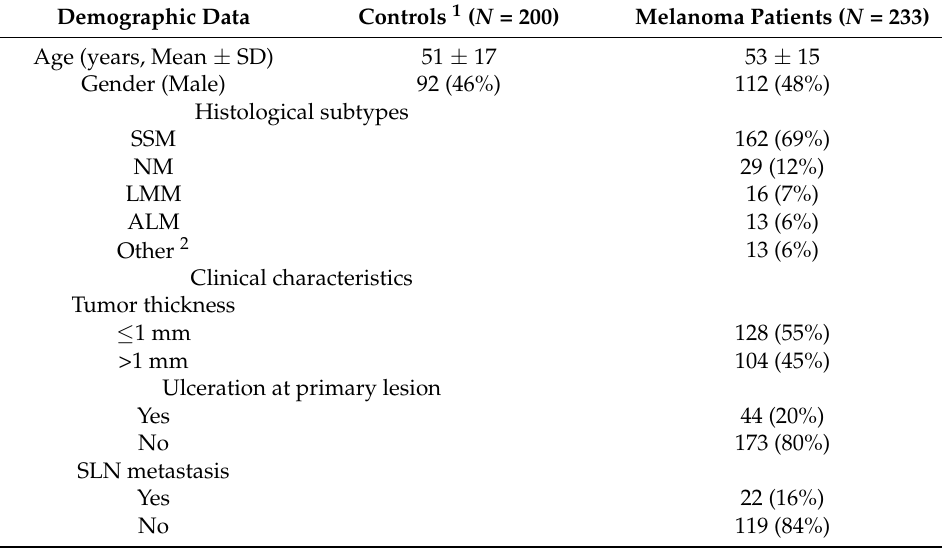
Table 1. Clinical and demographic characteristics of melanoma patients and